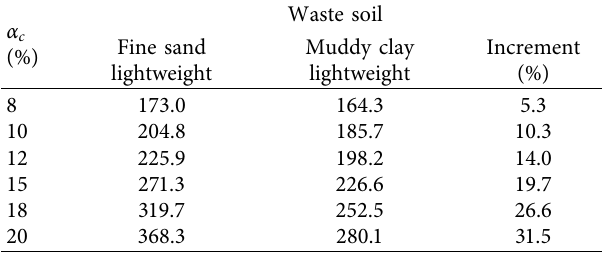
Table 3: Comparison of different waste soil lightweight (7 days).